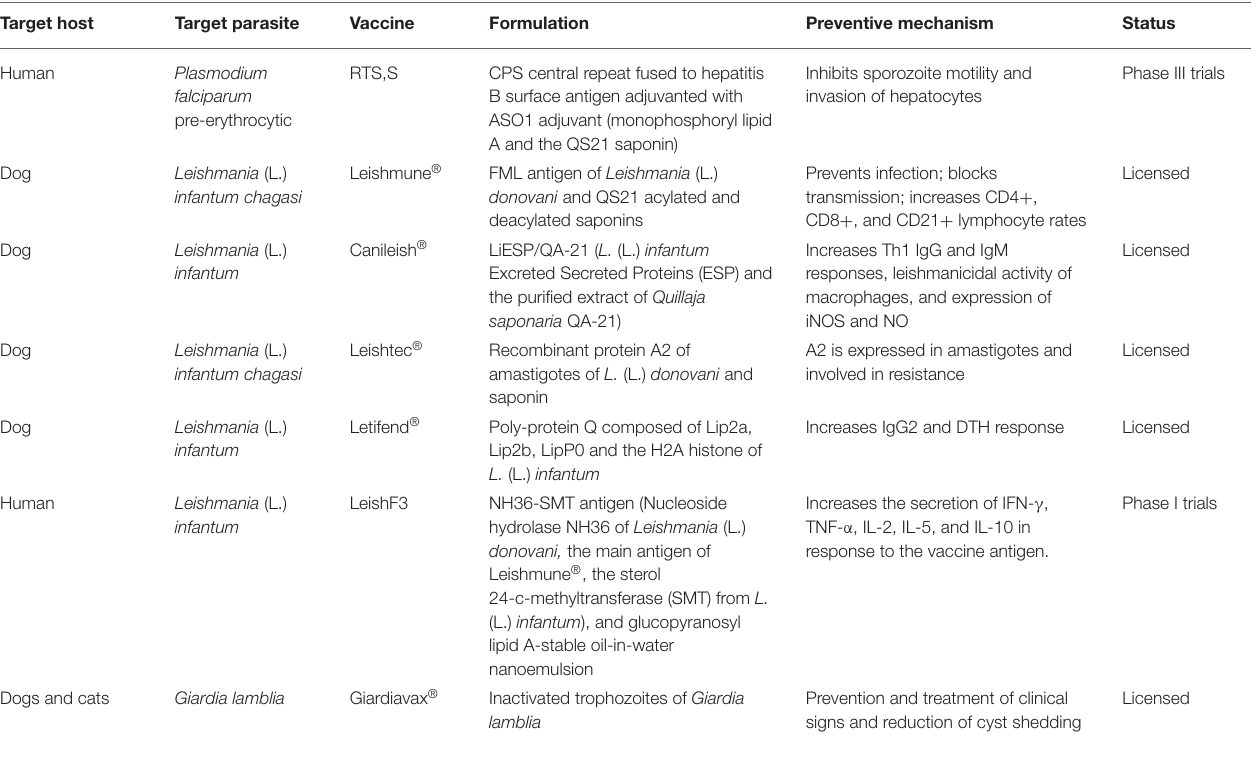
TABLE 1 | Current licensed anti-protozoal vaccines and those in the pipeline or at the pilot scale. Target